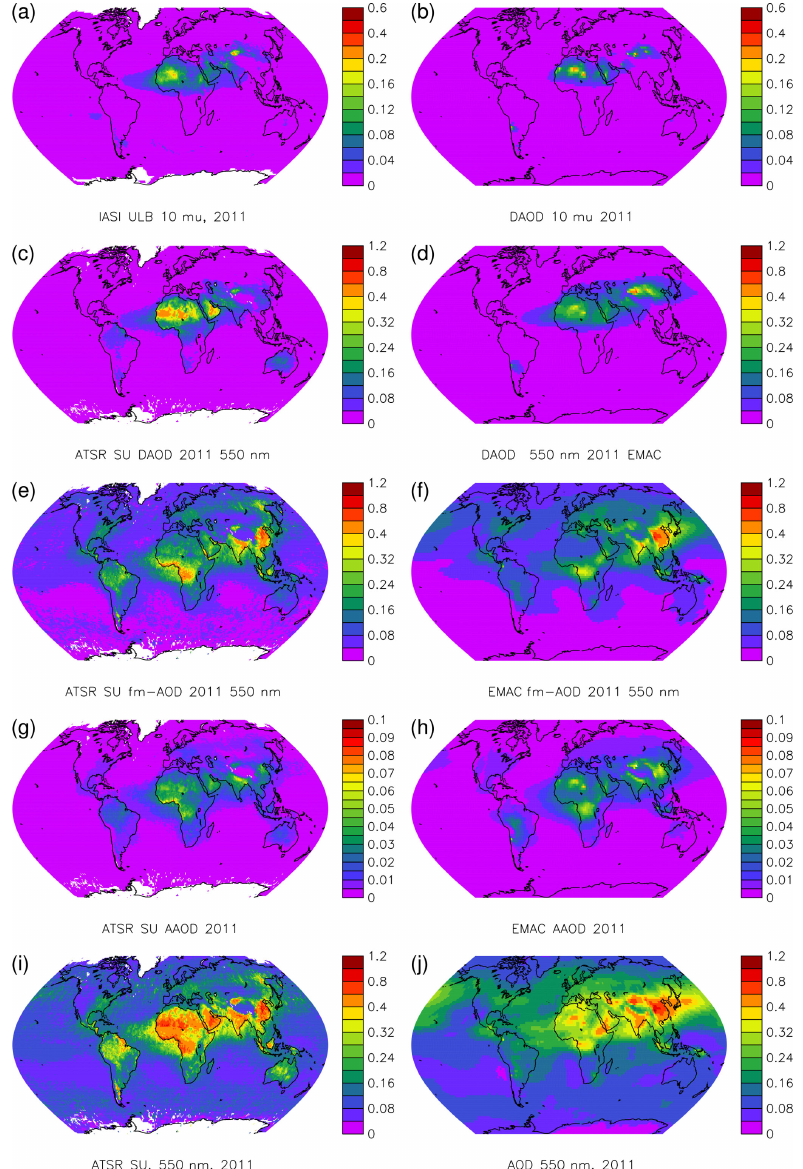
Figure 6. Observed (left) and simulated (right). (a, b) 10µm dust AOD (DAOD) for IASI and EMAC; (c, d) 0.55µm DAOD from ATSR and EMAC; (e, f) fine mode AOD; (g, h) absorbing AOD (AAOD) and (i, j) total AOD for ATSR (SU) and EMAC in T63L90 resolution, annual mean